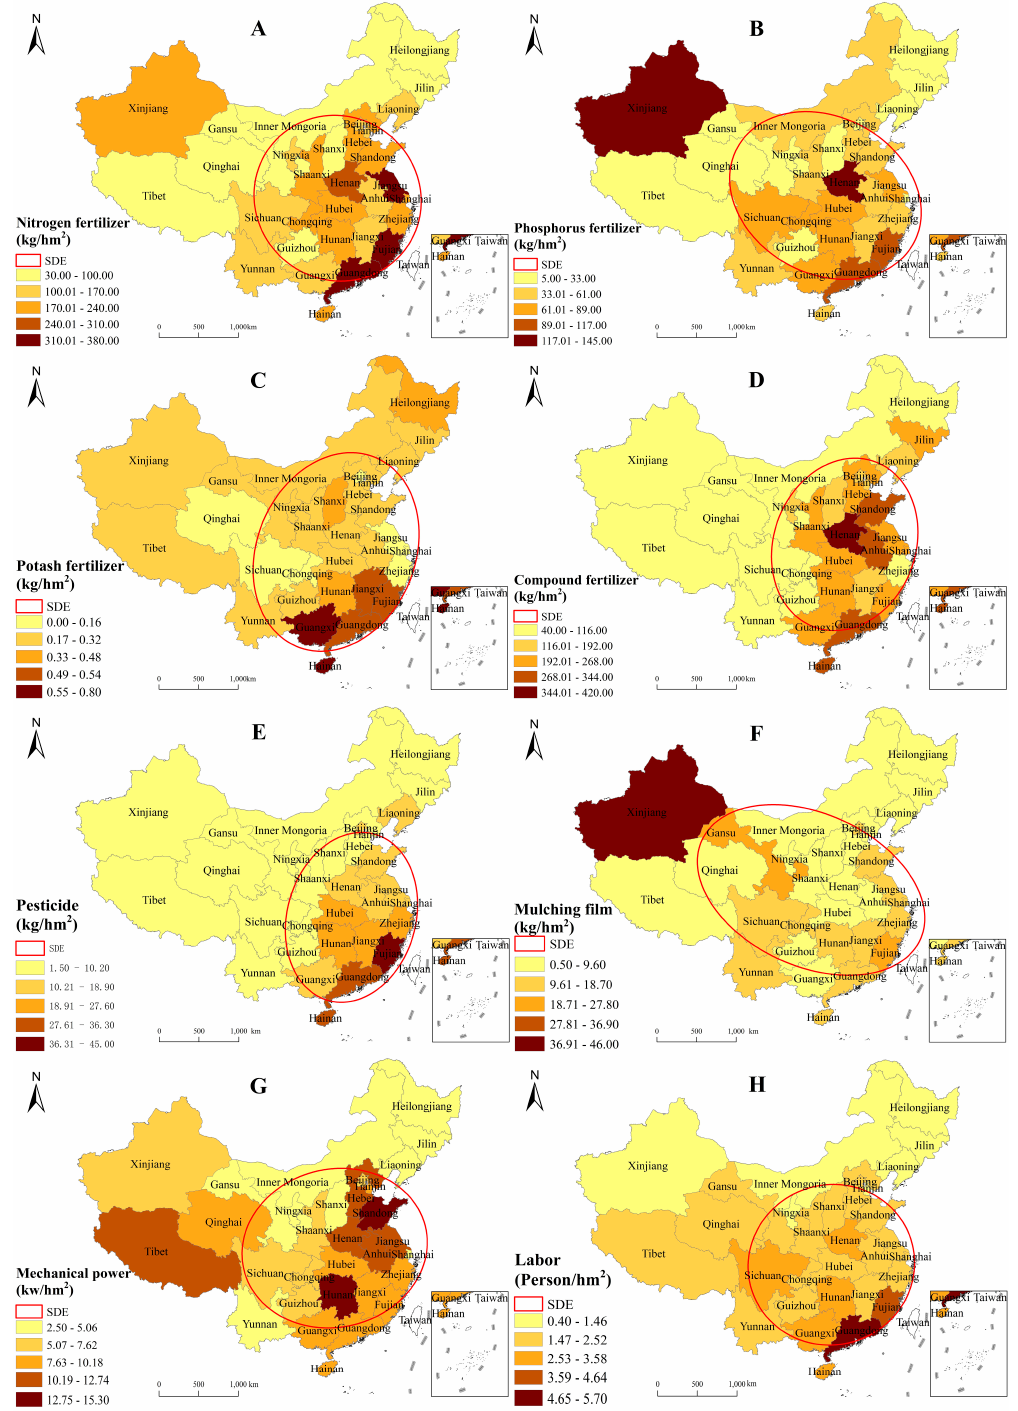
Figure 5. Input of production materials on per unit area of arable land in 2018. Figures 8 and 9 represent the output on per unit area of arable land in 2008